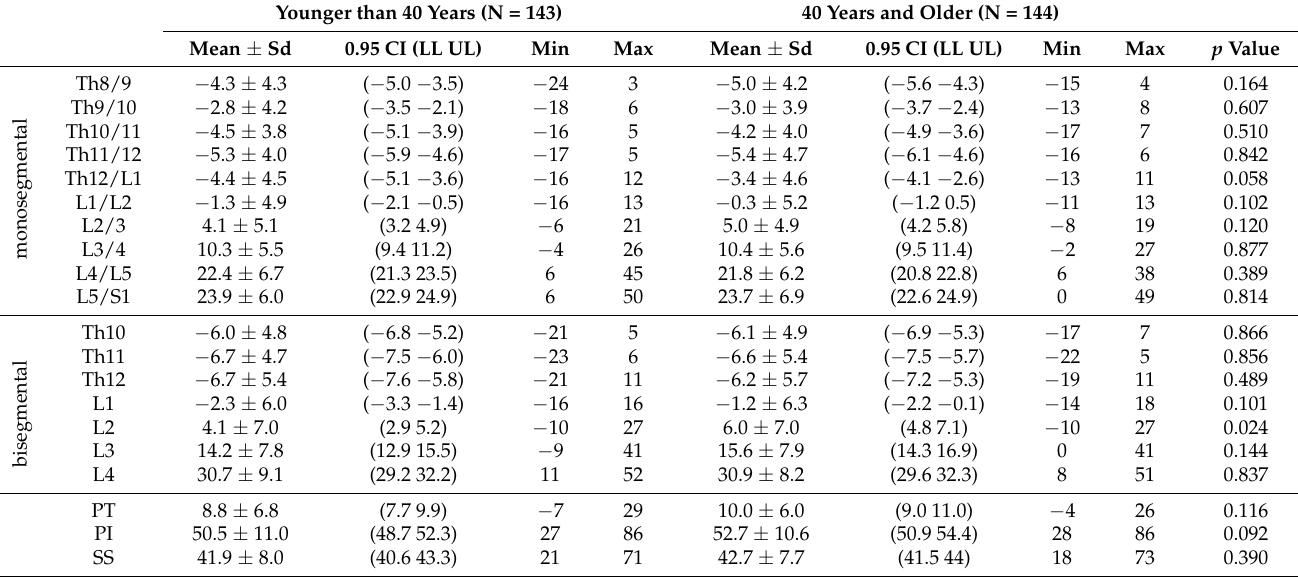
Table 1. Angles of thoraco-lumbar mono- and bisegmental EPA and spino-pelvic parameters (PT: pelvic tilt, PI: pelvic incidence, SS: sacral slope) of younger and older adults. Data are given as mean and standard deviation, the lower (LL) and upper limits (UL) of the 95% confidence interval (CI), minimum and maximum, and p-value of pairwise